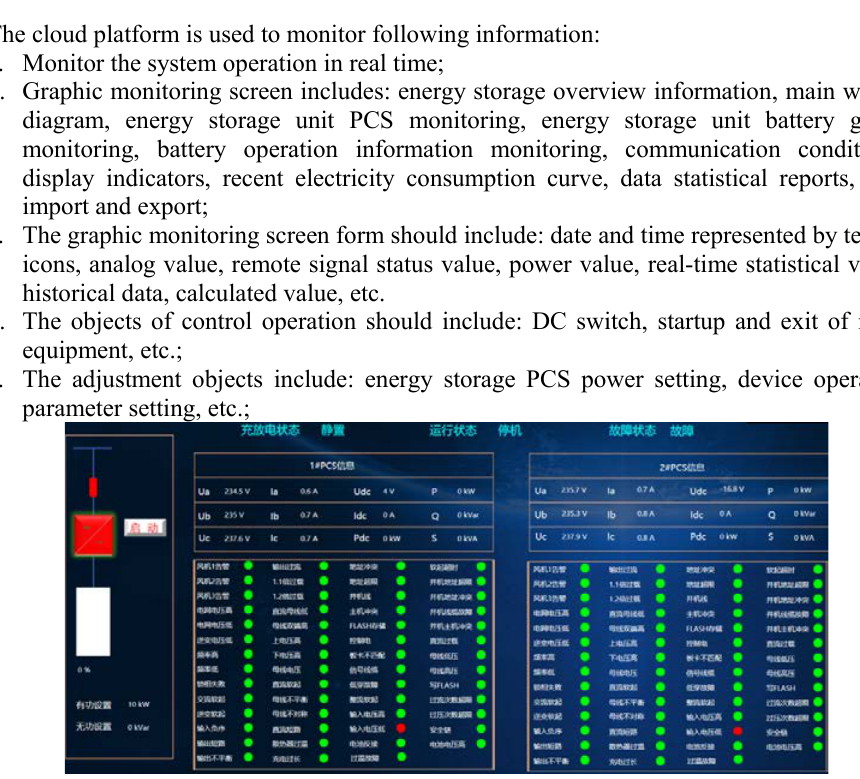
Fig. 8. Cloud platform